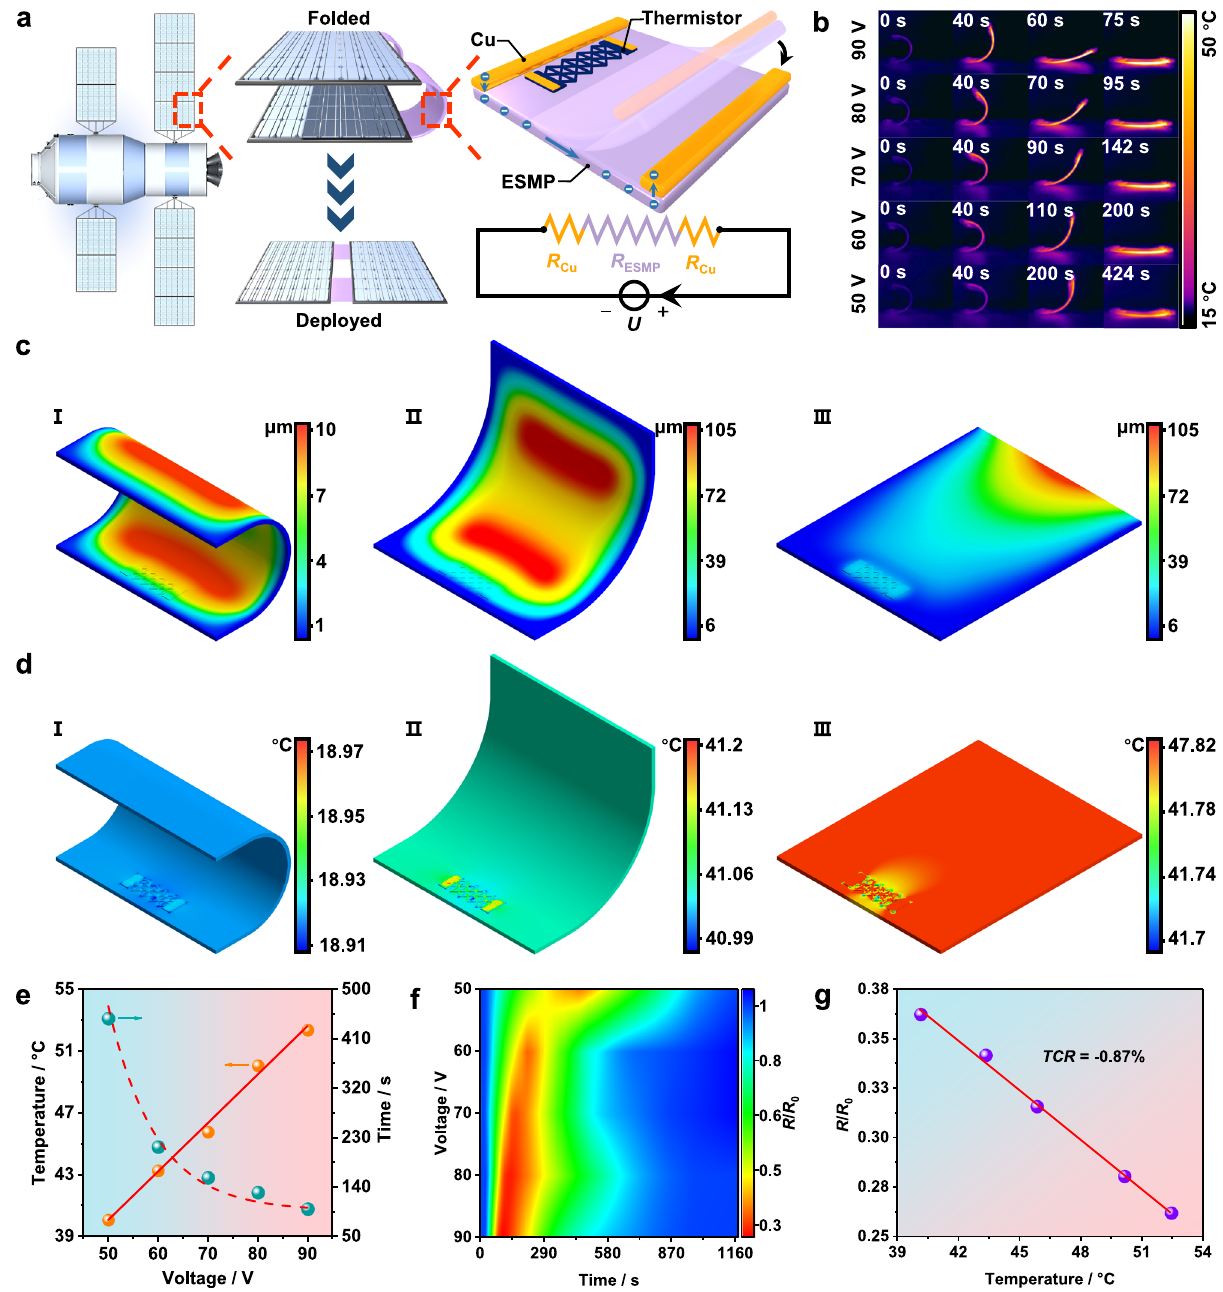
Fig. 5 Construction and operation of temperature monitoring system. a Schematic illustration of solar array deployment process and electro-induced shape memory polymer composites (ESMP) device design. b Thermal images of system deployment process under different voltages. Finite element analysis of ( c ) total instantaneous deformation and ( d ) temperature distribution at different stages. e Functional relationship among fi nal deployment temperature, time and applied voltage. f Resistance changes of the thermistor attached on ESMP and ( g ) the resultant Temperature coef fi cient of resistance ( TCR )